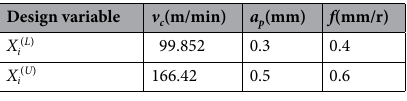
Table 1. Parameter range of design variables.